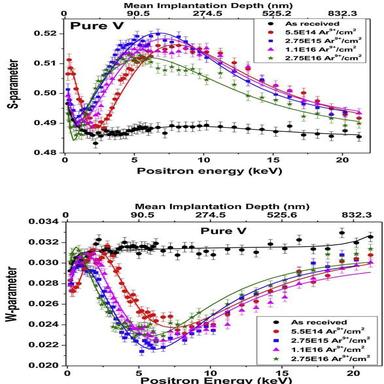
(a) & (b): S-E and W-E profiles of as received and ion irradiated pure V samples. The solid lines through the data points show the fitting of the profiles using VEPFIT.